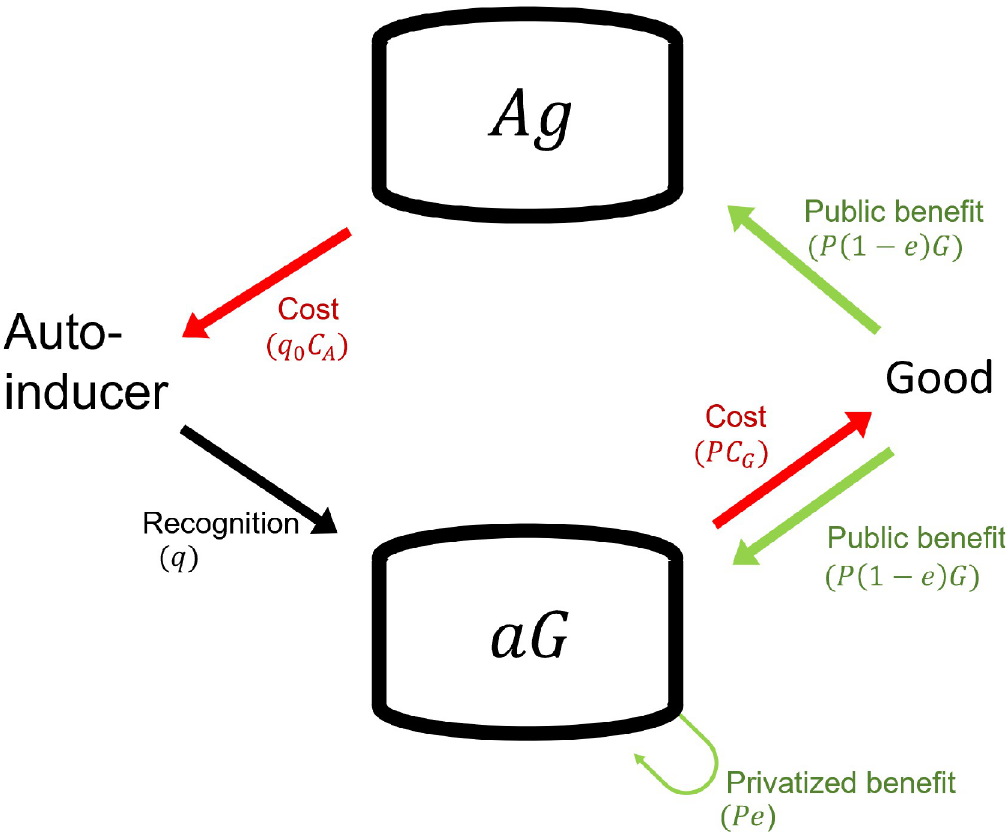
Fig 4. A schematic relationship for the social interaction between functionally complementary strains, i.e., the autoinducer-producer/good-nonproducer ( Ag ) and the autoinducer-nonproducer/good-producer ( aG ). Please see Table 2 and Section 6D for the definition of letters ( q , C etc.) and the equations used for the analysis, respectively. All mathematical A analyses assumed an unstructured population.